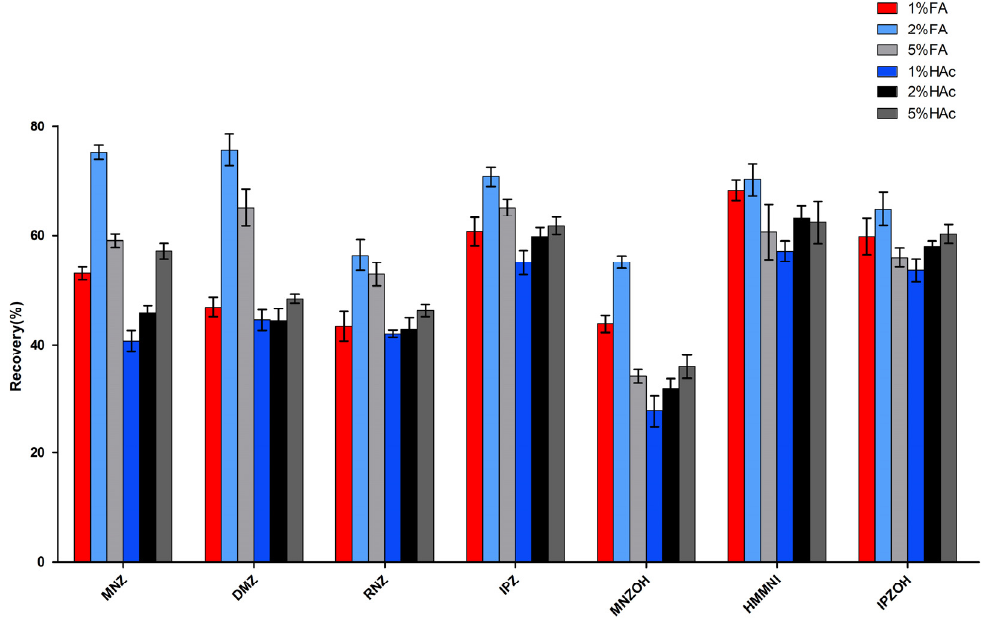
Figure 1. Recoveries of different dissolving solution. Table 1. Slope ratios of matrix-matched standard versus pure standard in solvent.